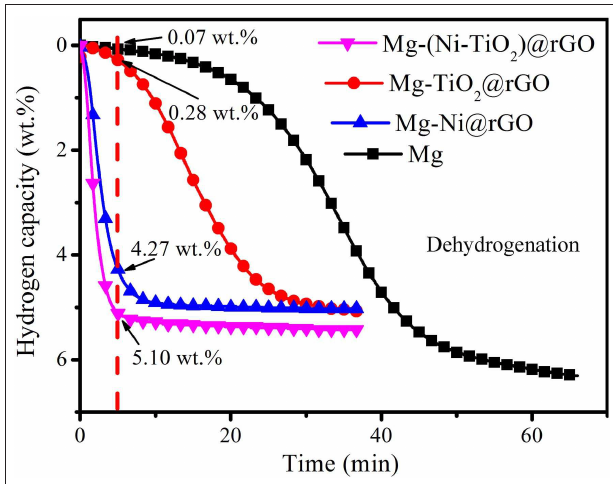
FIGURE 6 | Dehydrogenation curves of Mg and Mg-Ni@rGO, Mg-TiO 2 @rGO, and Mg-(Ni-TiO 2 )@rGO composites performed at 573K.